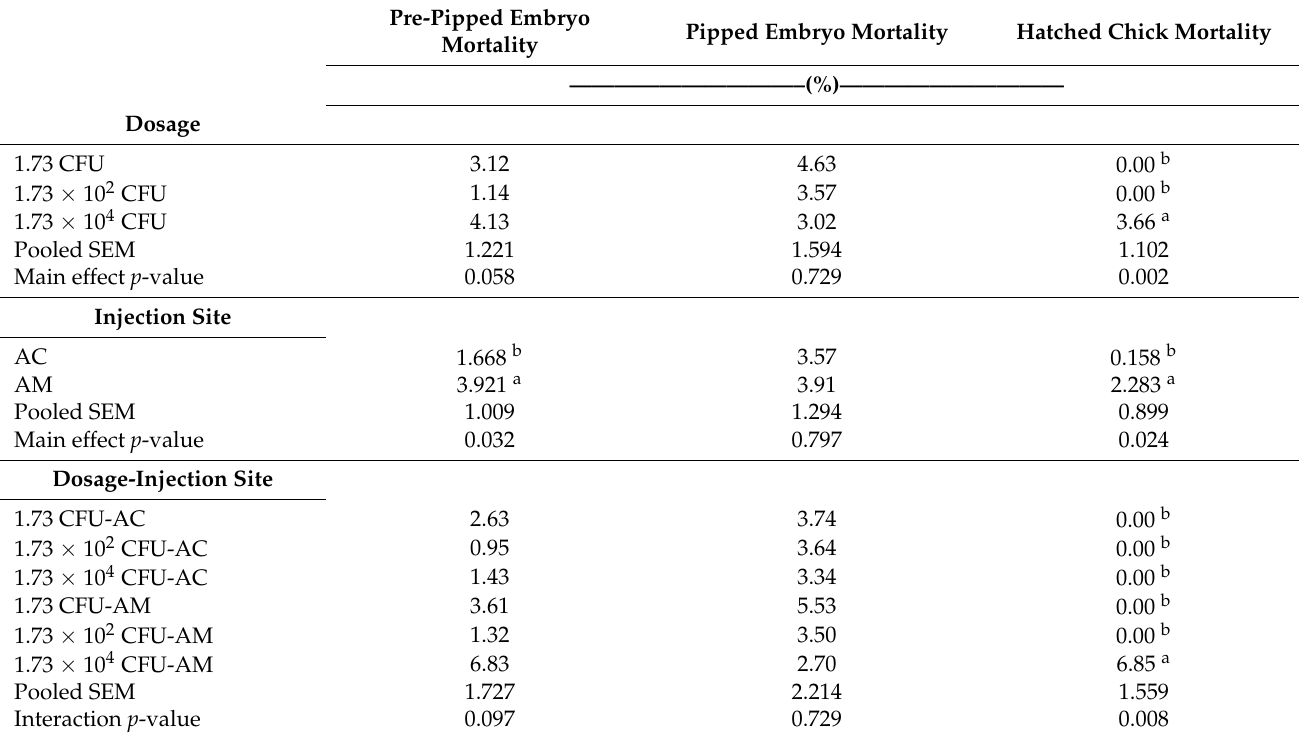
Table 6. Main and interaction means of post-injection pre-pipped and pipped embryonic mortalities, and hatched chick mortality determined at pull time (22 days of incubation) 1 due to 6/85 MG dosage (1.73, 1.73 × 10 2 , and 1.73 × 10 4 CFU) and site of injection (air cell ( AC ) or amnion ( AM